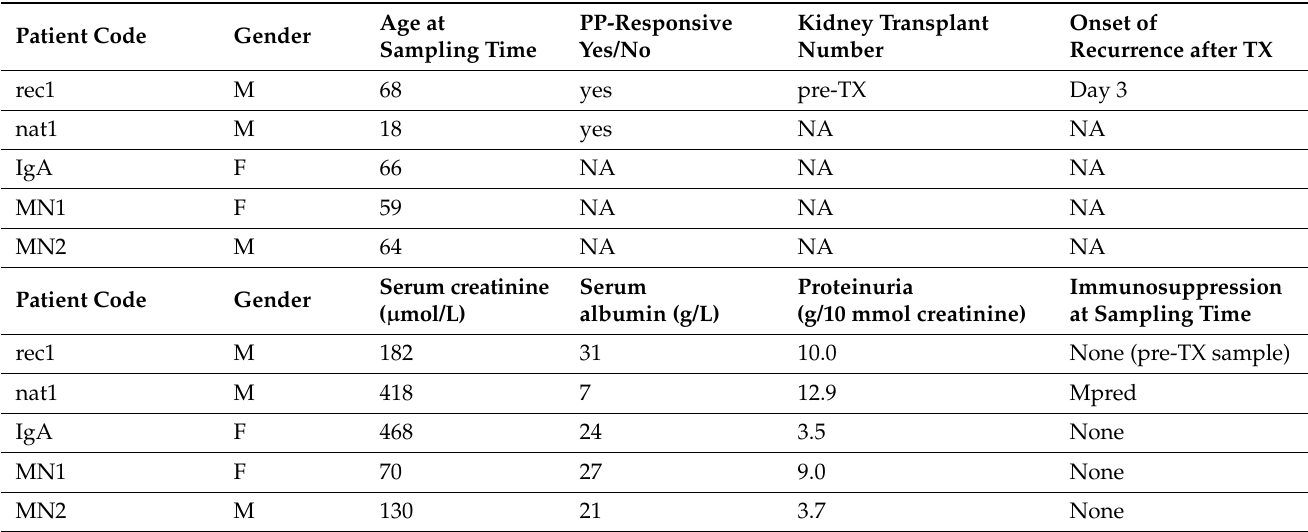
Table 2. Clinical characteristics of patients and disease controls used for kidney